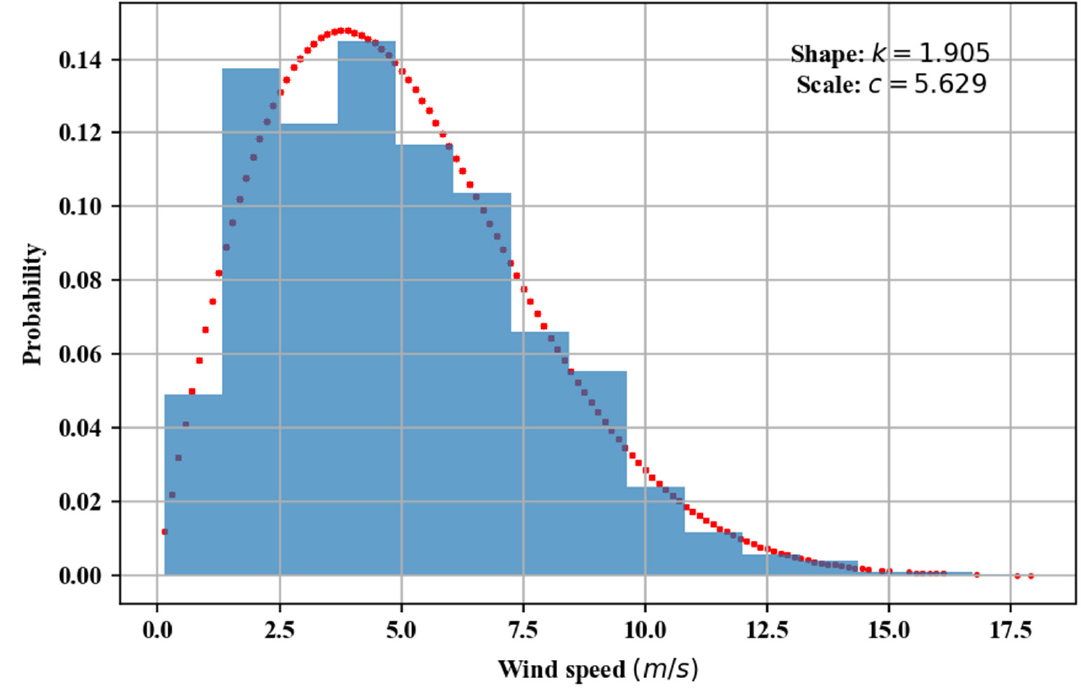
Figure 4. Actual and best-fit of the wind speed profile distribution.